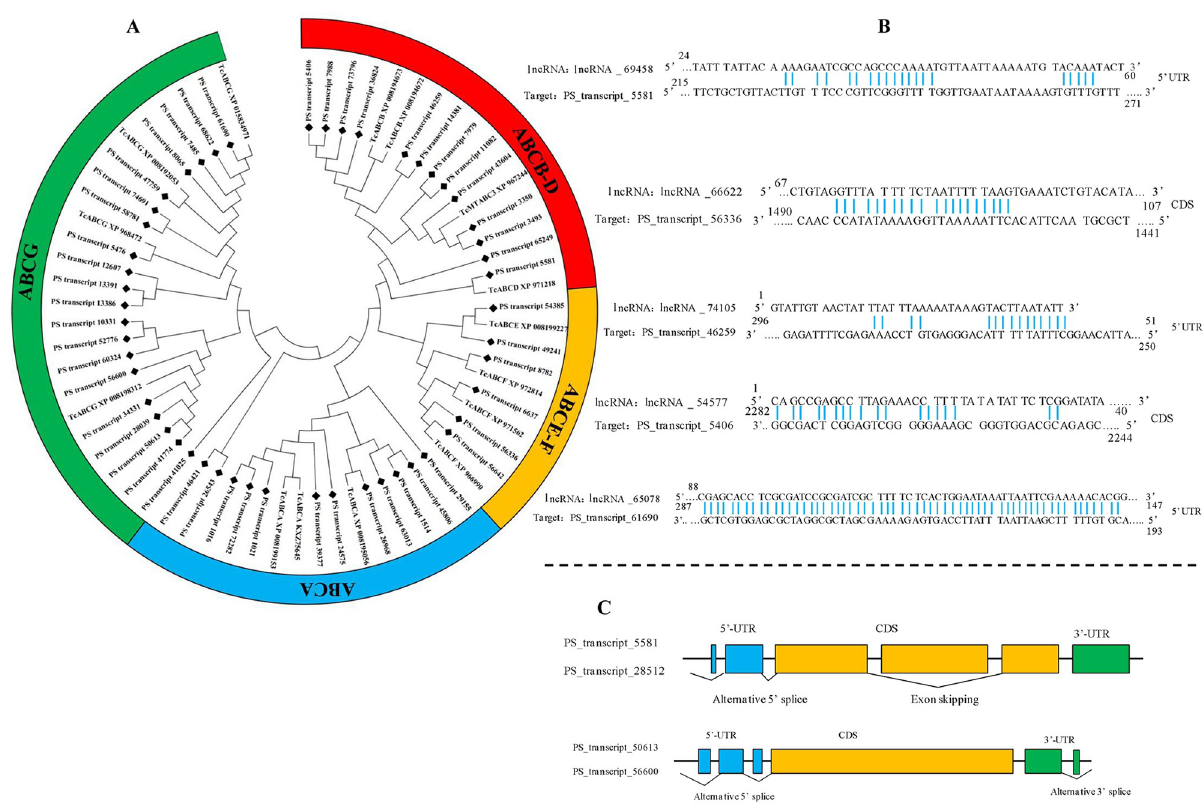
Fig 5. Sequence analysis, regulatory lncRNA, and splicing events of ABCs. A. Phylogenetic analysis of transcripts encoding ABCs; B. binding sites of lncRNA and ABCs; C. splicing events of ABCs.